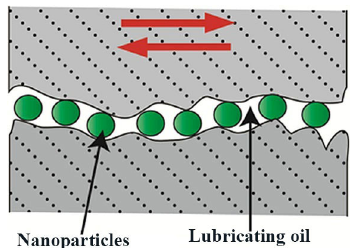
Fig. 7 Schematic of ball bearing mechanism of